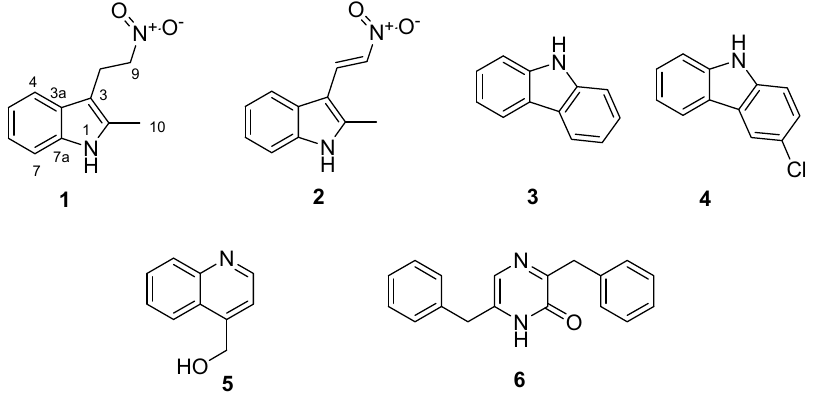
Figure 1. Secondary metabolites isolated from Labilithrix luteola .